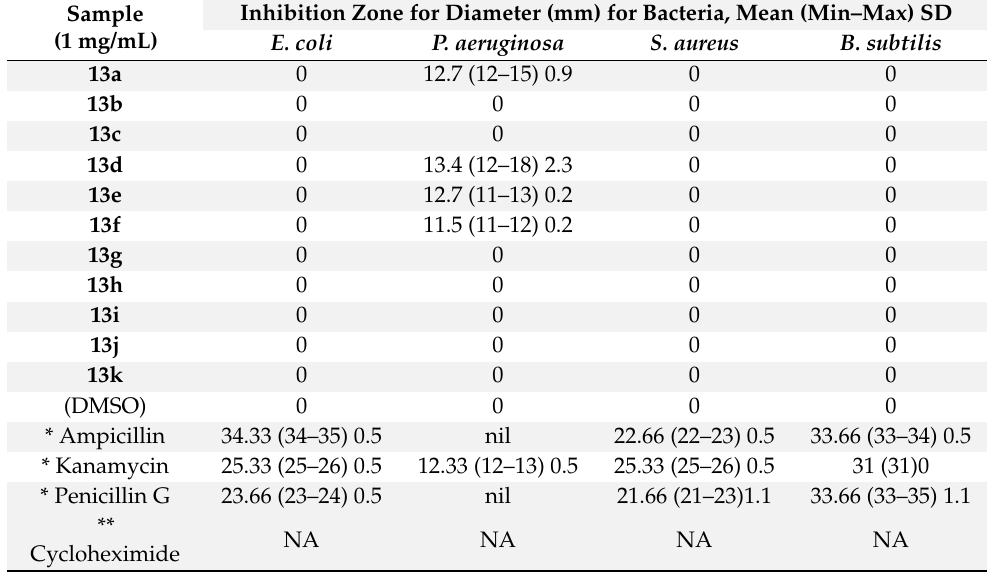
Table 3. Diameters of the inhibition zones for the tested compounds against bacteria.